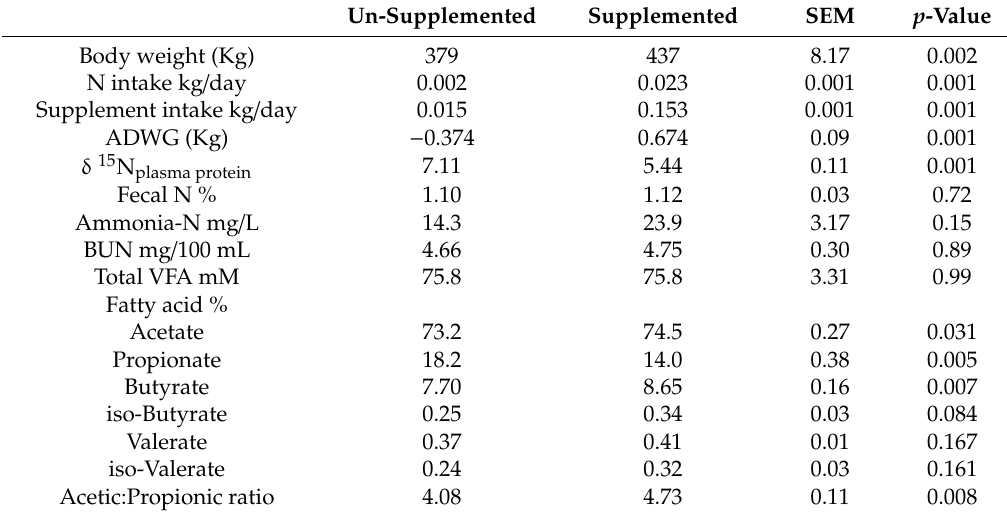
Table 1. Rumen fermentation parameters, body weight, ADWG, fecal N, BUN, and plasma nitrogen fractionation ( δ 15 N) in pregnant heifers grazing tropical forage at late-dry season, two months on supplementation or